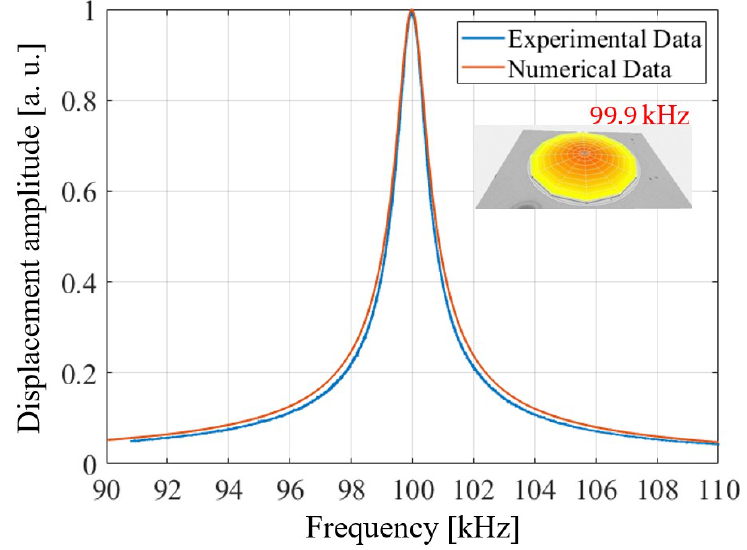
Figure 8. Comparison between experimental and numerically computed transversal normalized displacement frequency amplitude spectrum at the center of the PMUT by means of ANSYS 17.2 with experimentally computed fundamental mode shape at 99.9 kHz ( top right